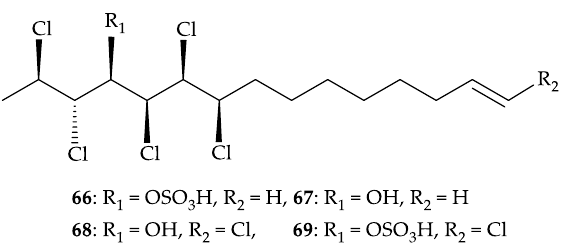
Figure 10. Structures of polychlorolipids 66 – 69 .